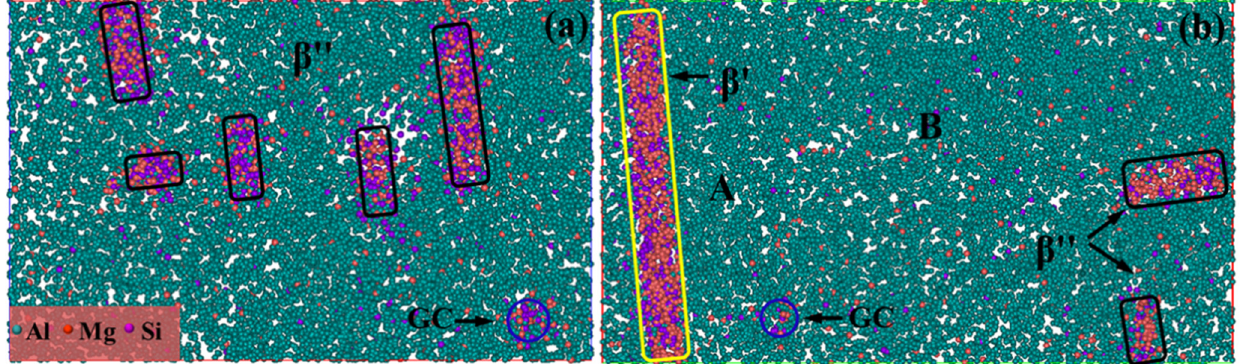
Figure 6. Typical 1 nm thick atom maps, showing the distribution of Al, Mg, and Si atoms at ( a ) NA10 min-AA (65 nm × 40 nm) and ( b ) NA1440 min-AA (70 nm × 40 nm).